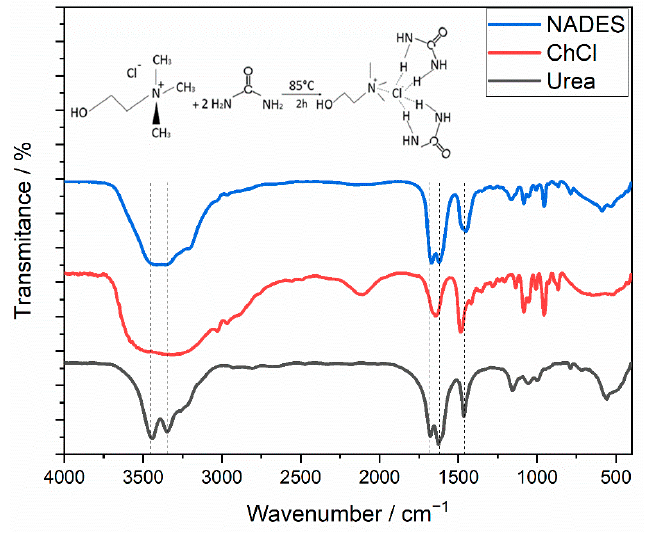
Figure 6. FTIR spectra of precursors: urea (bottom), choline chloride (middle), and synthetized NADES (urea/ChCl top).